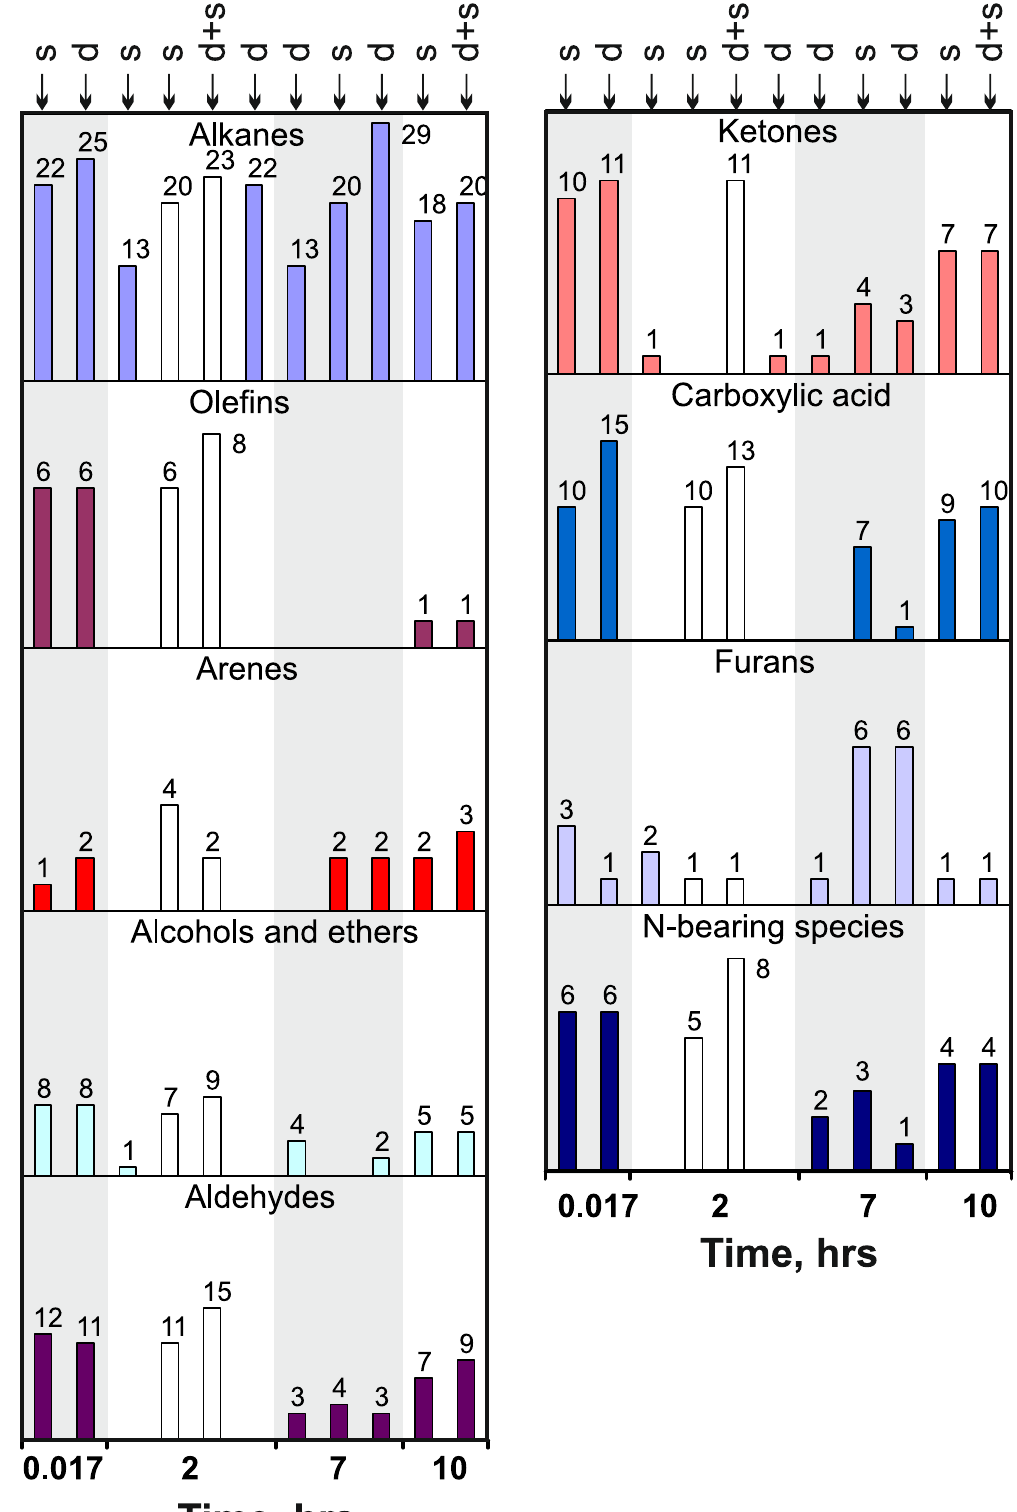
Figure 1. Diversity of alkanes, alkenes, and oxygenated hydrocarbons revealed by GC-MS analysis in quenched C-O-H-N fluids at 6.3 GPa, 1400 °C, MMO-buffered f H 2 and run durations from 0.017 to 10 hours. Symbols on top show starting compositions of charges for fluid generation: d = docosane; d + s = docosane + stearic acid mixture; s = stearic acid. White columns are unquenched samples cooled down at 1 deg/s. Grey and white bands show run